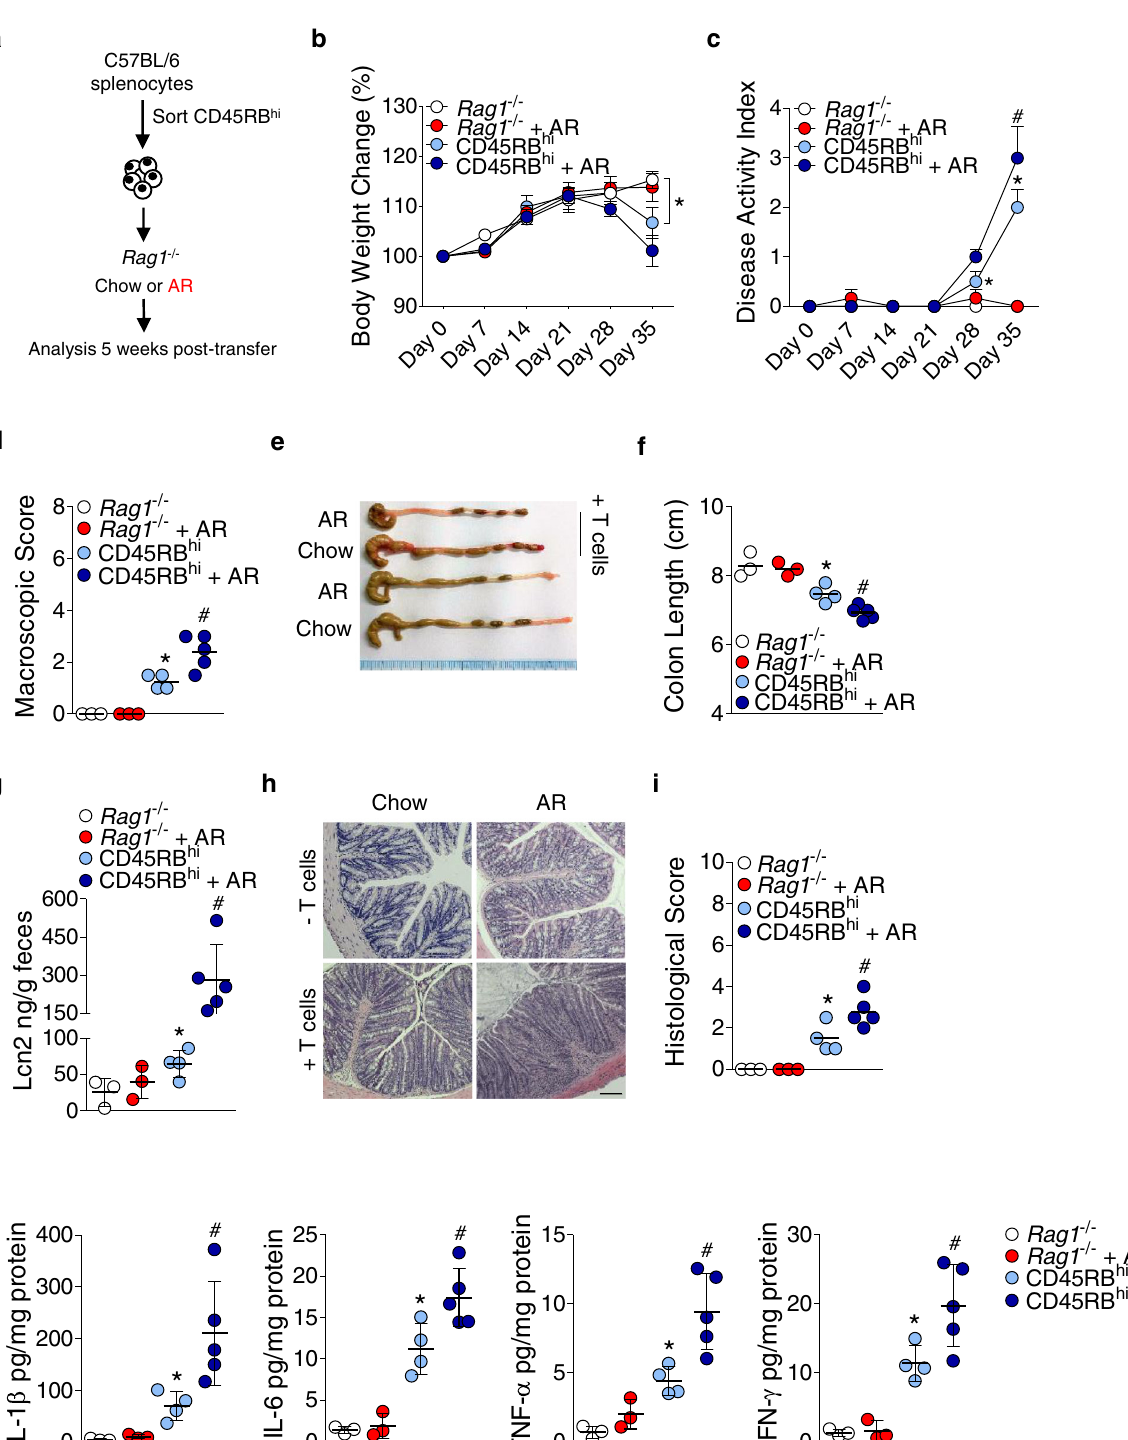
i Histologicalscore. j ColonicIL-1 β ,IL-6,andTNF- α ,andIFN- γ levels. b , c Datawere analyzed by two-way ANOVA with post hoc Bonferroni ’ s test and are expressed as mean±SEM ( n =3 for Rag1 − / − , and Rag1 − / − + AR; n =4 for CD45RB hi ; n =5 for CD45RB hi +AR). d – j Data were analyzed by one-way ANOVA with post hoc Bon- ferroni ’ s test and are expressed as mean or mean±SD ( n =3 for Rag1 − / − , and Rag1 − / − + AR; n =4 for CD45RB hi ; n =5 for CD45RB hi +AR). Signi fi cance denoted by * p <0.05, # p <0.05, where * p <0.05 versus Rag1 − / − , and # p <0.05 versus CD45RB hi . Source data are provided as a Source Data